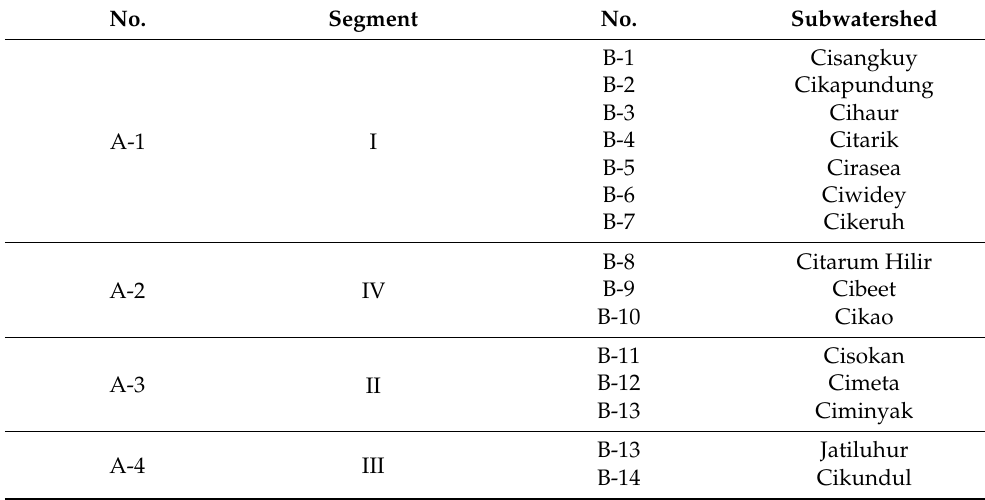
Table 3. Order of priority for the Citarum River management